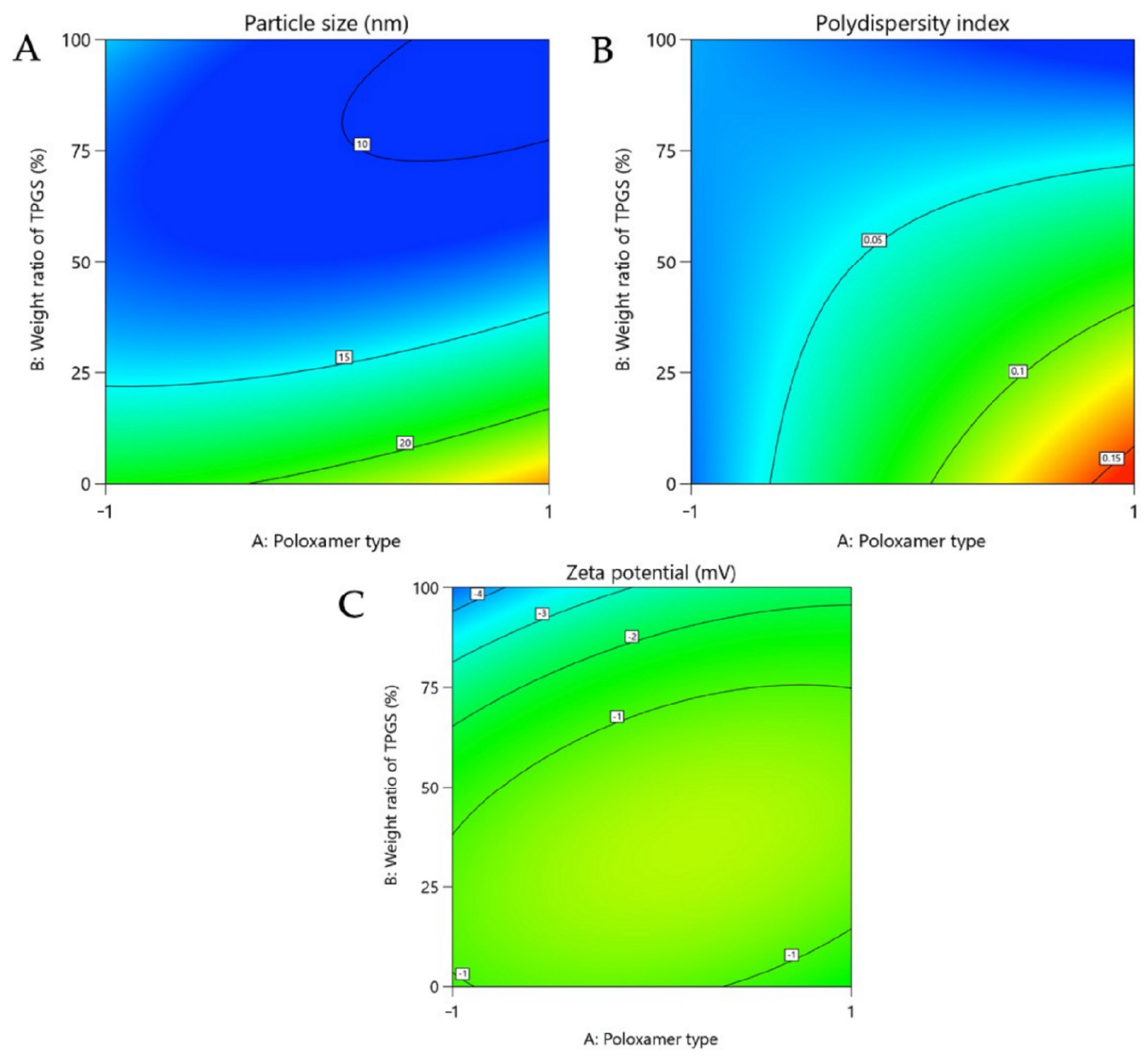
Figure 6. Contour plot showing relative effect of poloxamer type and weight ratio of TPGS on the size ( A ), the polydispersity index ( B ) and the zeta potential ( C ).